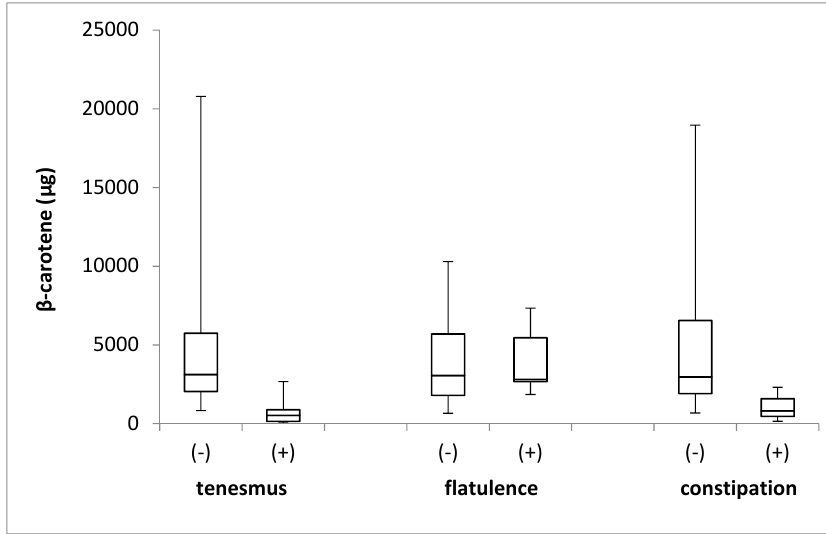
Figure 3. The box plots of β -carotene intake in groups of individuals stratified by the analyzed symptoms of tenesmus, flatulence and constipation. (-) symptom not declared; (+) symptom